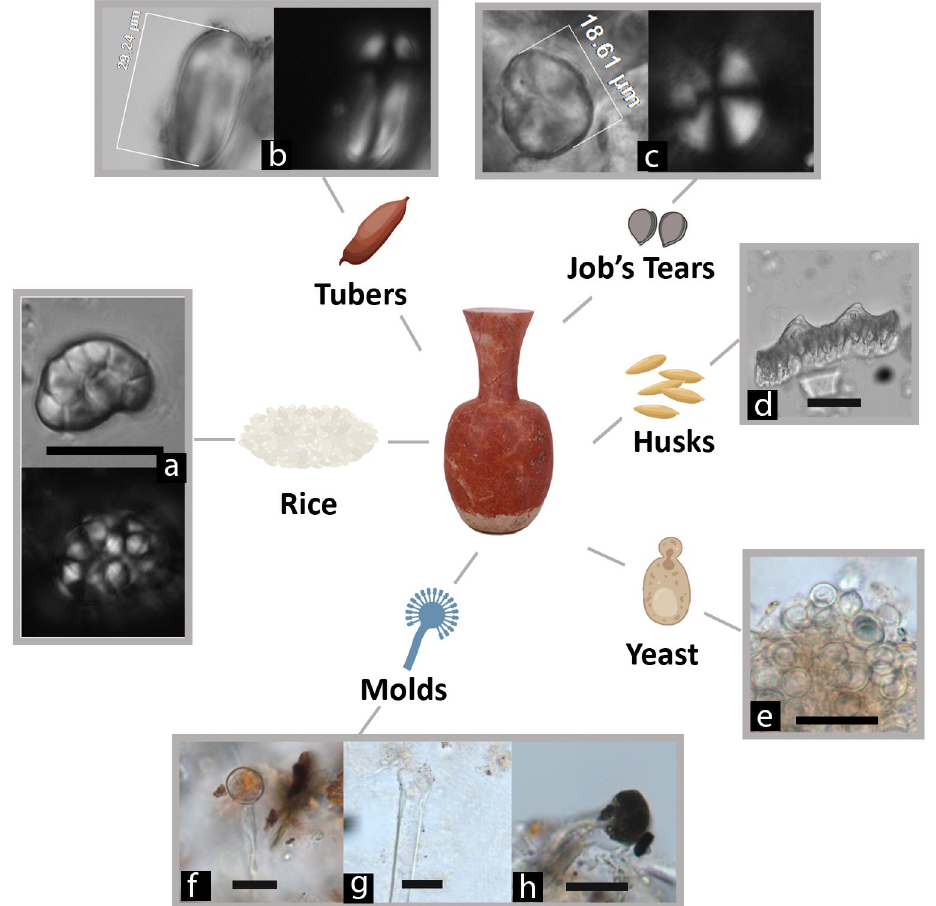
Fig 9. Beer-related microfossil remains. (a) Rice starch granules; (b) A starch granule from an unidentified USO; (c) A starch granule from Job’s tears, showing a characteristic Z-shaped arm; (d) A double-peak phytolith from rice husk; (e) Yeast cells in budding process; (f) and (g) vesicle/sporangia without phialides/spores attached, compared with Aspergillus oryzae in Fig 6; (h) Black sporangia connecting to sporangiophores, compared with Rhizopus in Fig 6 (scale bars: 20 μ m).